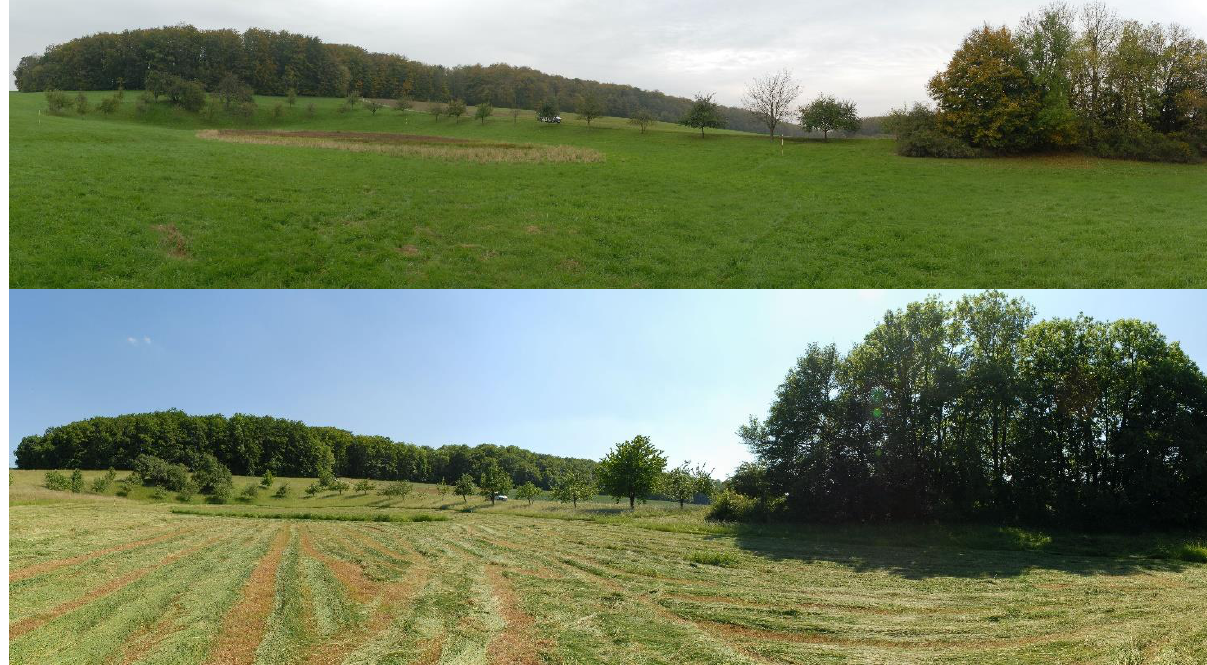
Figure 2. AOI captured with the camera mounted on the laser scanner at a scan position in the middle of the karst depression, viewing towards southwest, in October 2014 (top) and June 2015